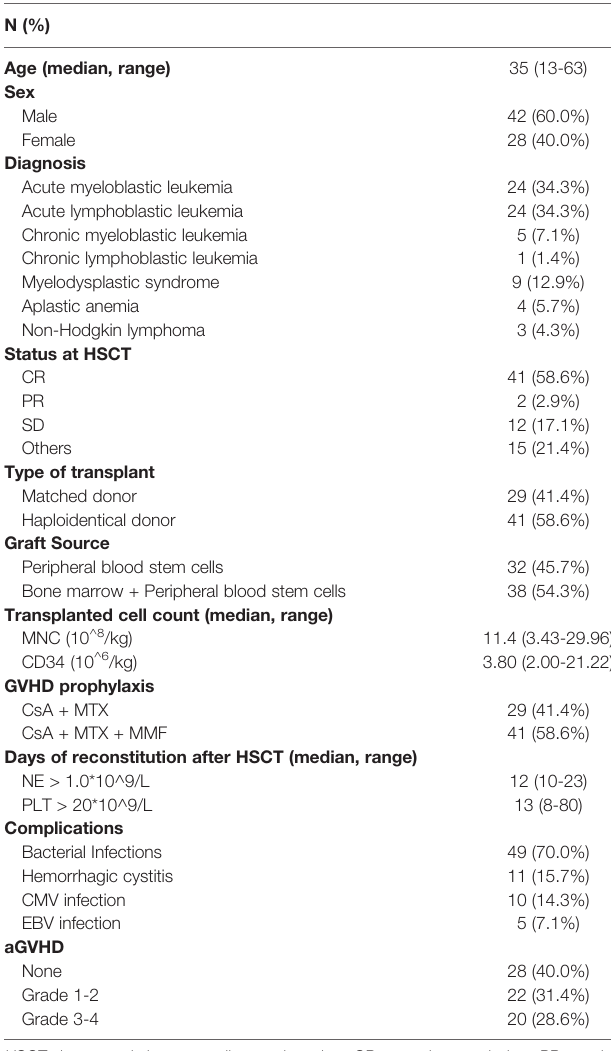
TABLE 1 | Clinical characteristics of patients with steroid-refractory chronic graft-versus-host